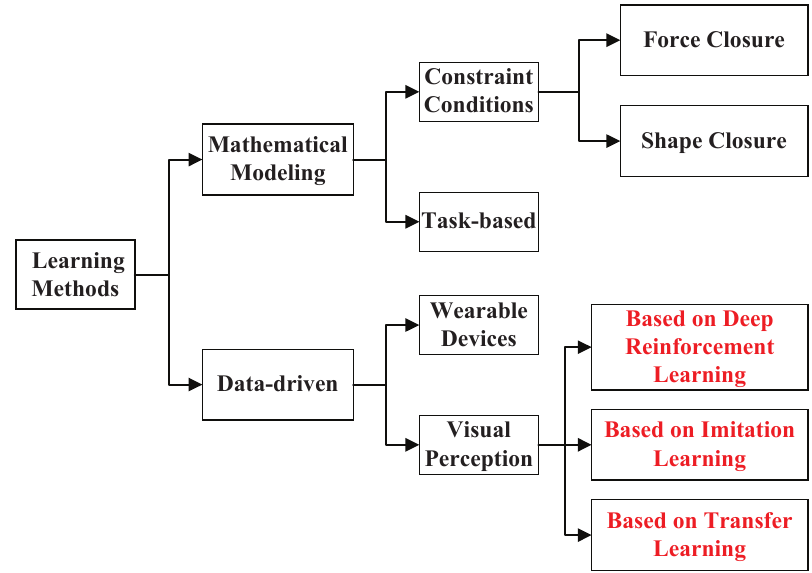
Figure 1. Overview of the structure of the